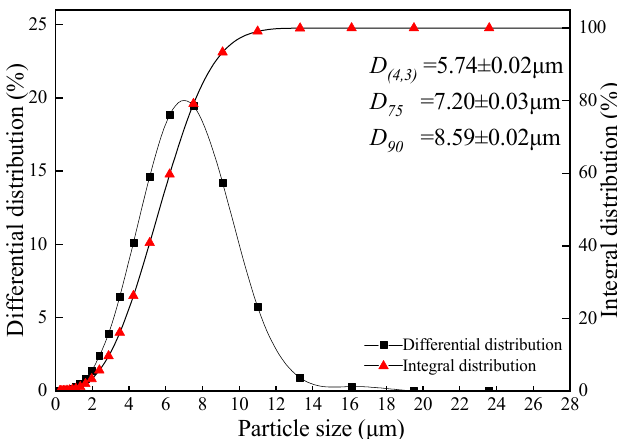
Figure 4. The particle size (mean ± SD, n = 3) distribution of red mud.